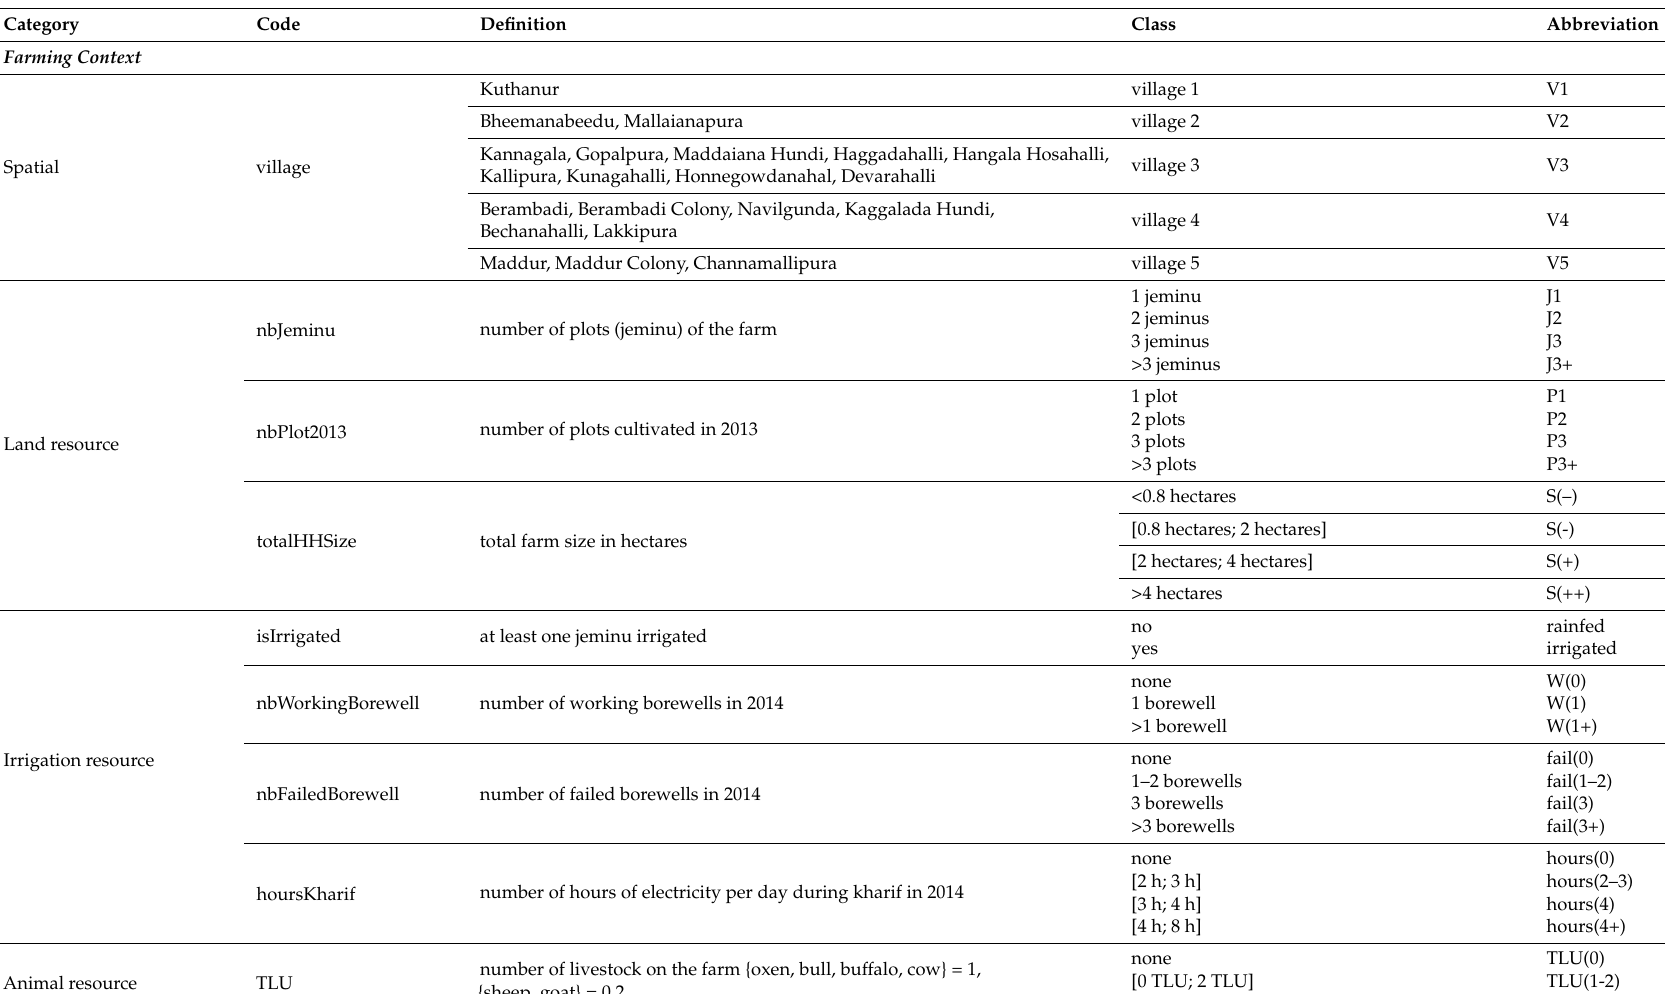
Table 1. Definition of variables for farming context, farm performance and farming practices used to generate the farm